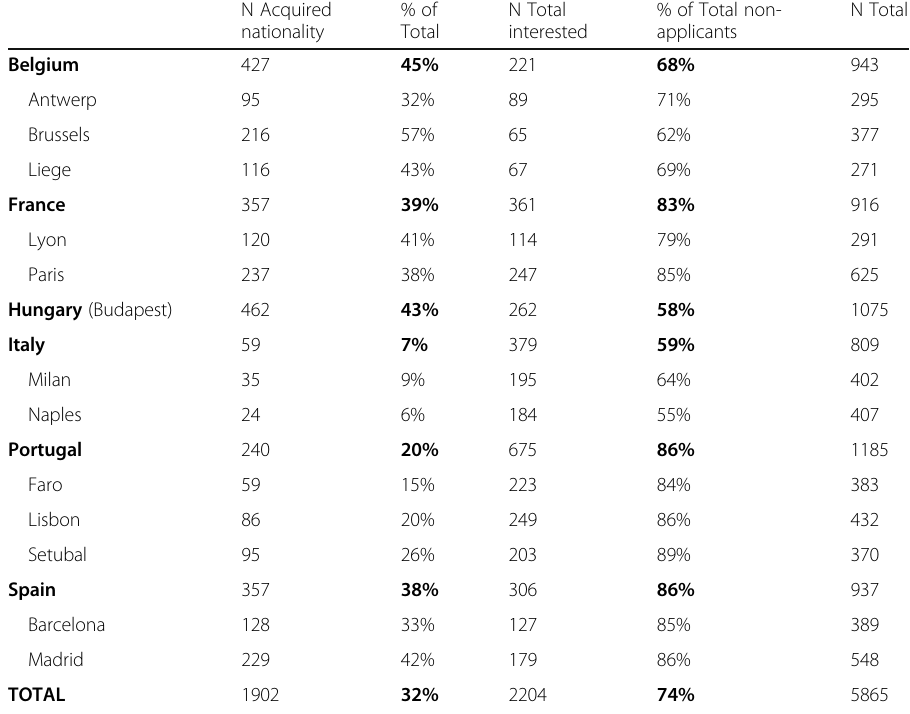
Source: Immigrant Citizens Survey